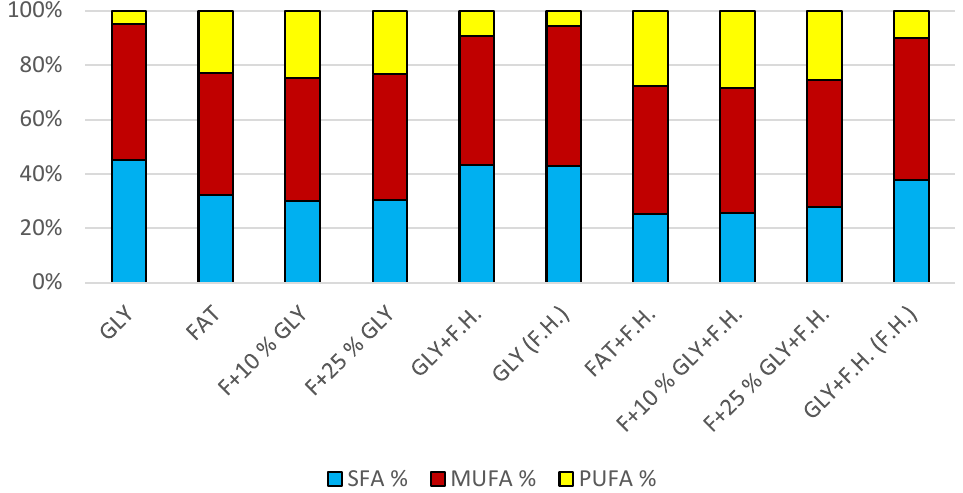
Figure 5. Lipid and biomass content in yeast strain Rhodotosporidium toruloides in conditions of C/N ratio 50.